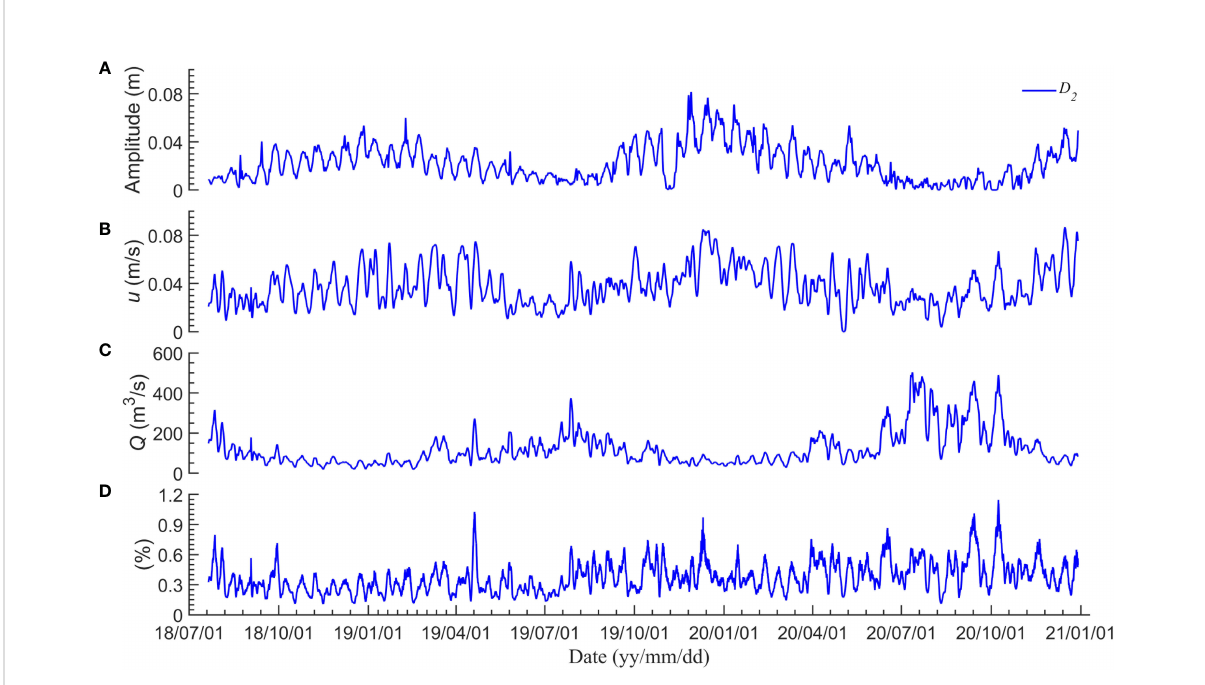
FIGURE 10 Time series of the results of the continuous wavelet transform (CWT) results at the Datong station. (A – C) Amplitude, velocity, and discharge in the semi-diurnal ( D 2 ) band; (D) Proportion of the semi-diurnal discharge in the total